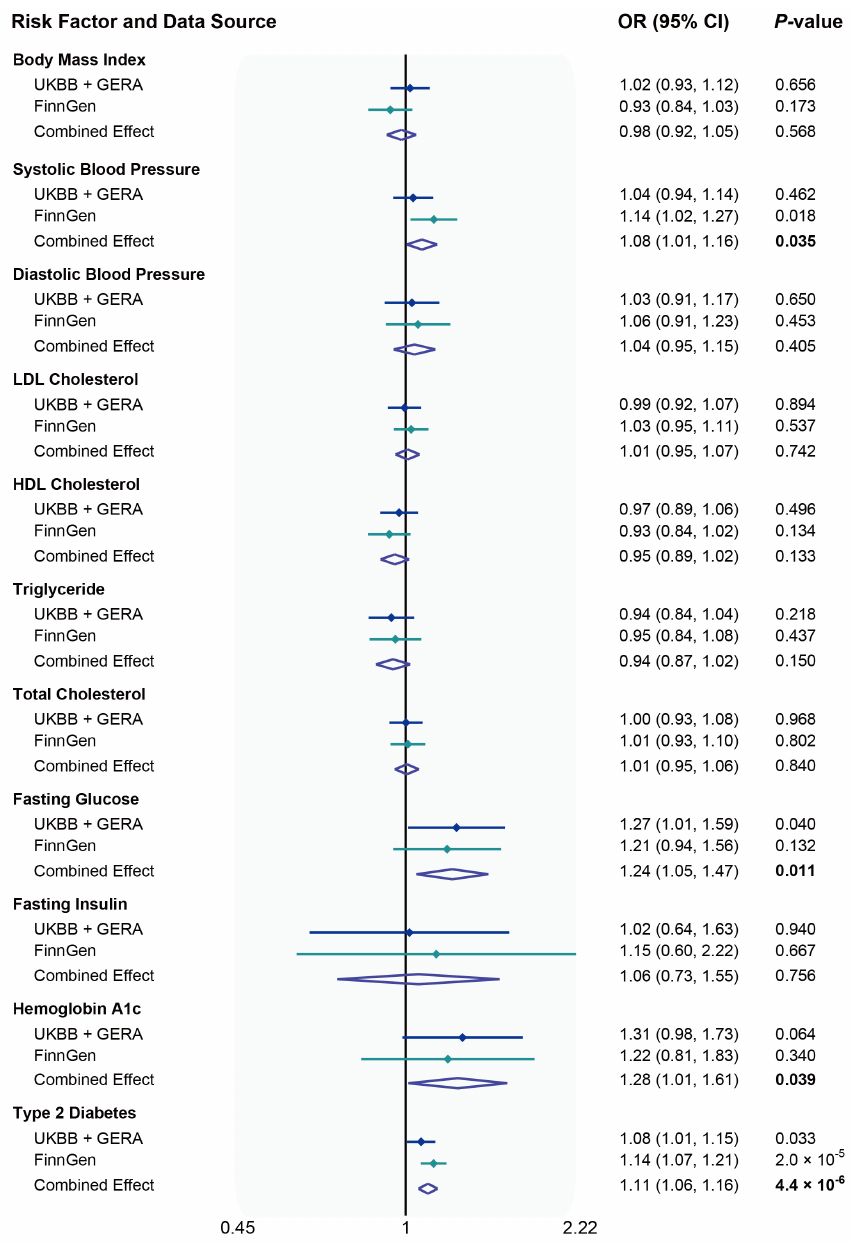
Figure 2. Associations of metabolic traits with glaucoma using the inverse variance-weighted